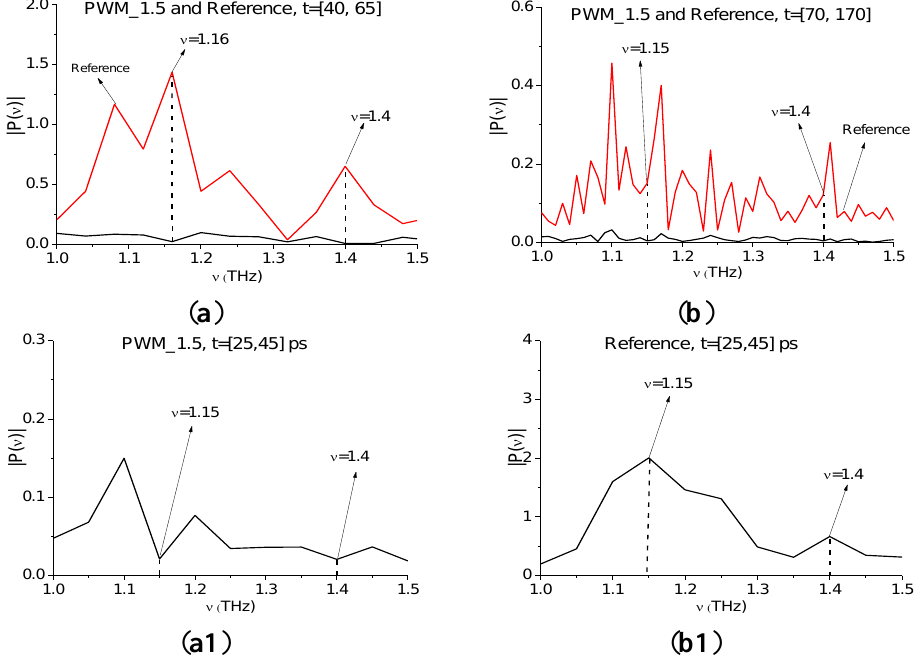
Figure 27. Fourier spectra of the PWM_1.5 signal and Reference signal, calculated in the time intervals t = [40, 65] ( a ) and t = [70, 170] ( b ); spectrum of the signal PWM_1.5 ( a1 ) and Reference signal ( b1 ) for t = [25, 45]